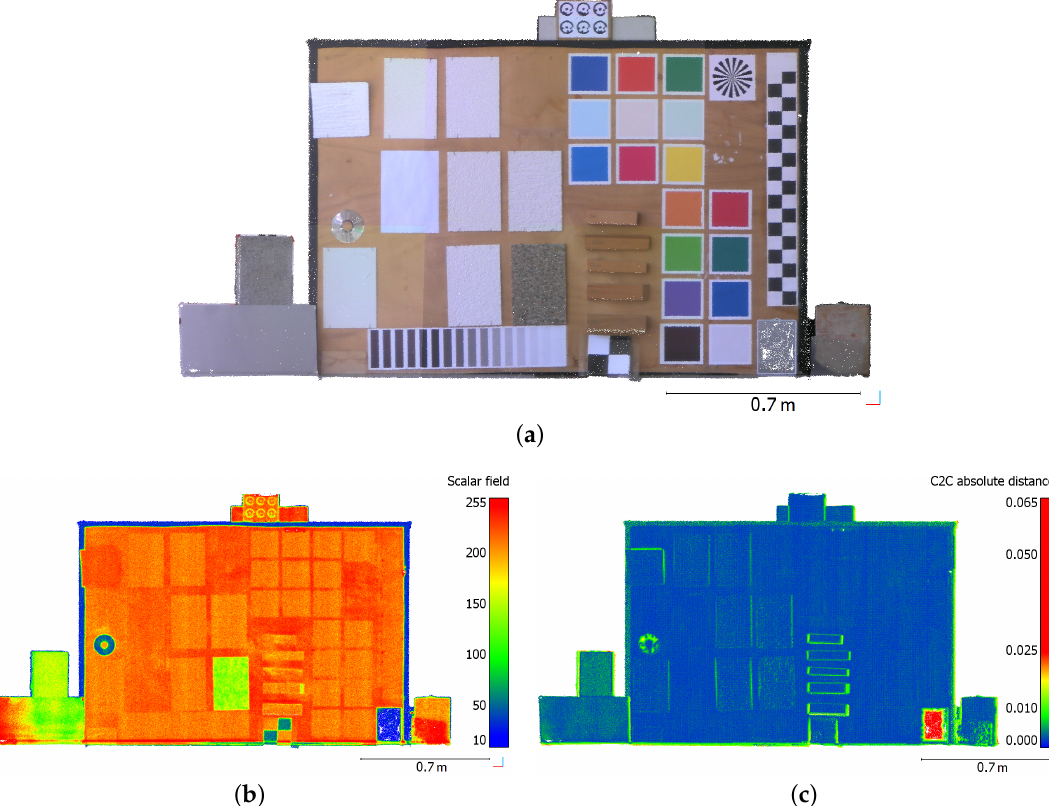
Figure 9. ( a ) Trimble SX10 colorized point cloud of a board composed of various color and material samples; ( b ) Visualization of intensity values returned by the laser scanner; ( c ) Cloud-to-cloud comparison between FARO Focus 3D and Trimble SX10 point clouds of the same board. Deviations (unit: m) are projected on SX10 point